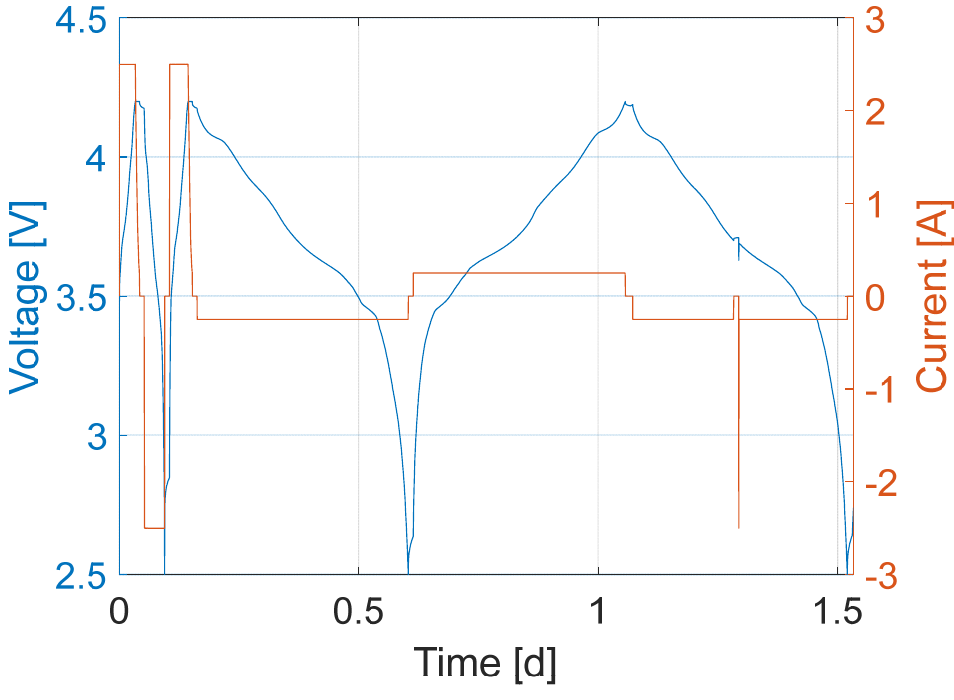
Figure 1. Check-up test to assess the